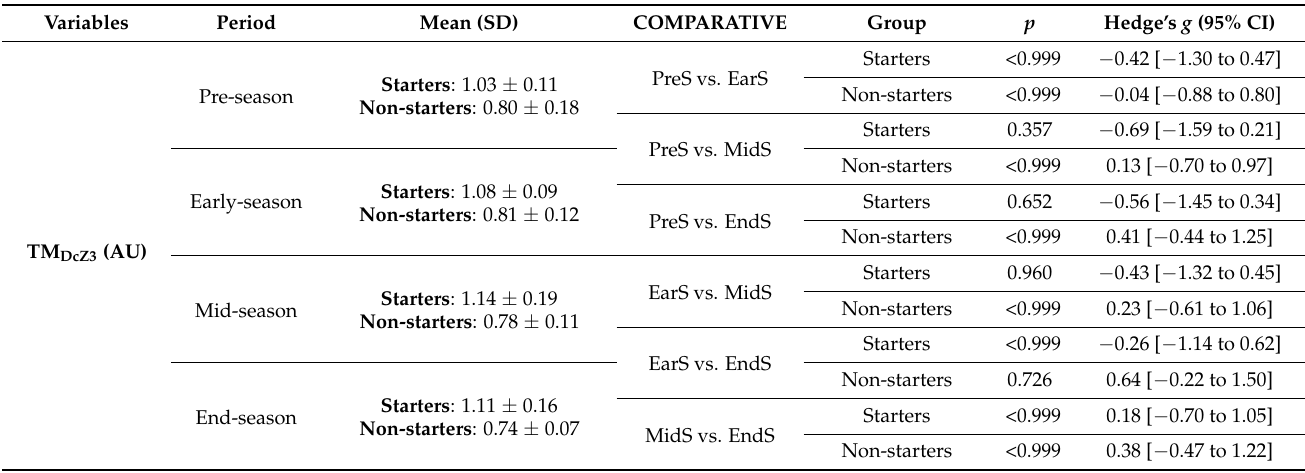
Figure 1. Pairwise comparisons between season periods in TM and TS in all AcZ for both non- and starter players. Abbreviations: TM, training monotony; TS, training strain; AU, arbitrary units; ( a ): TM AcZ1 , weekly average training monotony based on number of accelerations at Zone 1 (<2 m · s − 2 ); ( b ): TS AcZ1 , weekly average training strain based on number of accelerations at Zone 1 (<2 m · s − 2 ); ( c ): TM AcZ2 , weekly average training monotony based on number of accelerations at Zone 2 (2 to 4 m · s − 2 ); ( d ): TS AcZ2 , weekly average training strain based on number of accelerations at Zone 2 (2 to 4 m · s − 2 ); ( e ): TM AcZ3 , weekly average training monotony based on number of accelerations at Zone 2 (>4 m · s − 2 ); ( f ): TS AcZ3 , weekly average training strain based on number of accelerations at Zone 2 (>4 m · s − 2 ). Table 6. Intragroup differences for binary comparisons between season periods in TM and TS in DcZ3 for both non- and starter